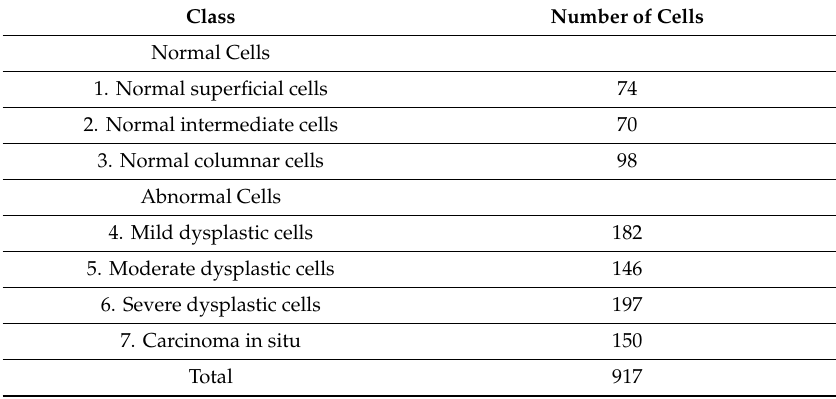
Table 1. Descriptions of seven-classes cells from the Herlev (single cells) dataset.